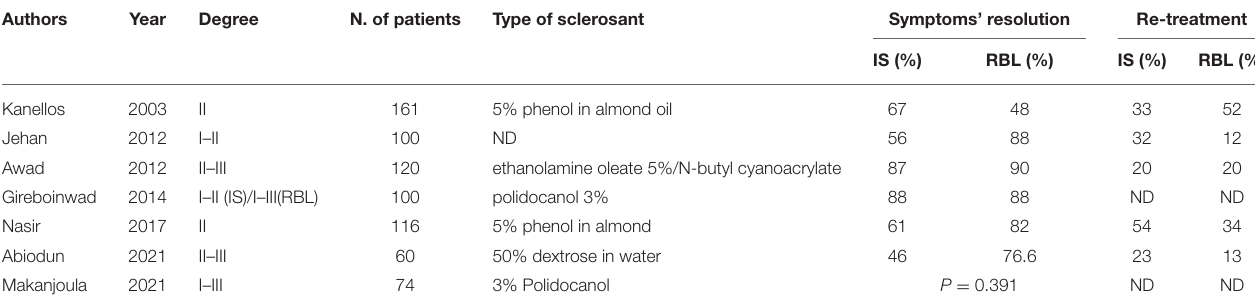
TABLE 1 | Data on symptoms’ resolution and need for re-treatment offered by RCTs comparing IS vs. RBL. Authors